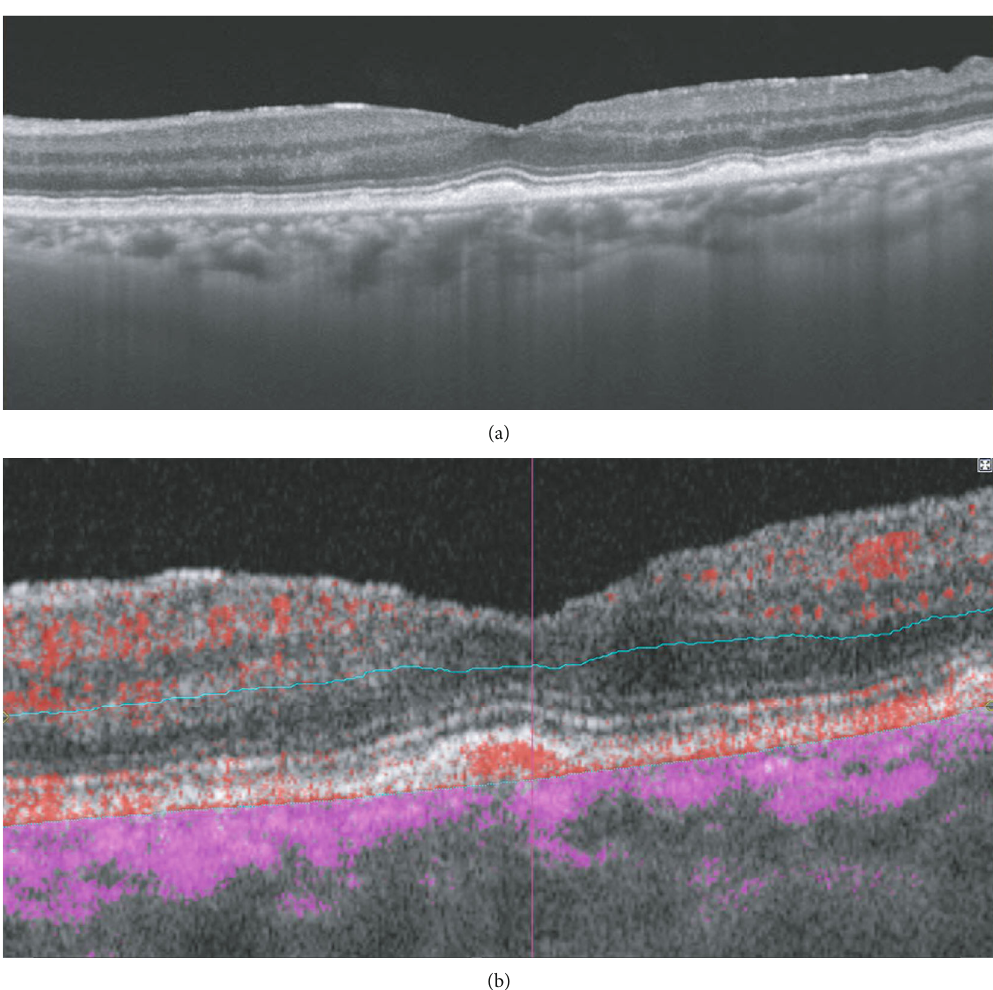
Figure 5: Horizontal swept-source optical coherence tomography (SS-OCT) B-scan (a) and horizontal B-scan SS-OCT angiography (b) at 13 months after presentation in the left macula.